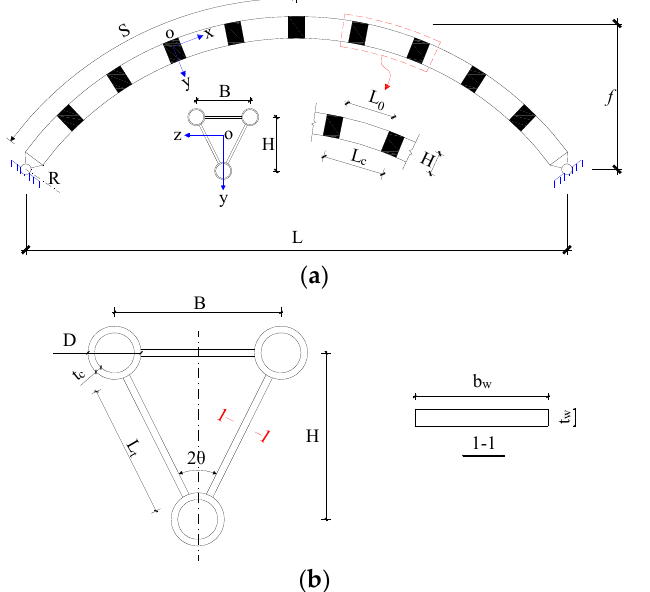
Figure 3. Related parameters of the arch: ( a ) global size of the arch; ( b ) cross-sectional parameters of the arch.